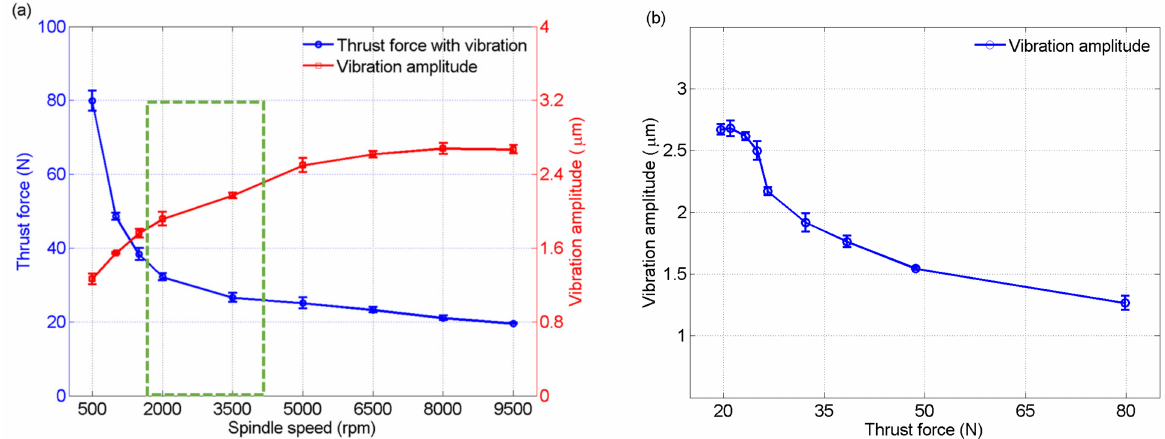
Figure 4. Variations of the thrust force and vibration amplitude in UVD: ( a ) with spindle speed data; ( b ) without spindle speed data.